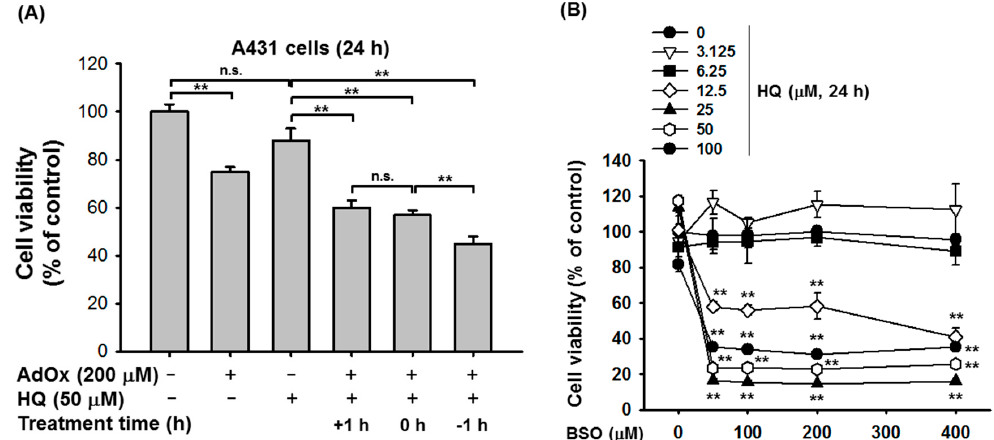
Figure 3. S ynergistic effect of HQ on the proliferation of A431 cells under AdOx- or BSO-treated conditions. ( A ) A431 cells were treated with HQ (50 μ M) and AdOx (200 μ M) for 24 h, and cell viability was determined via MTT assay. +1 h, HQ treatment 1 h after AdOx treatment; 0 h, HQ and AdOx treatment at the same time; and − 1 h, HQ treatment 1 h before AdOx treatment. ( B ) A431 cells were treated with the indicated doses of HQ and BSO for 24 h, and cell viability was determined via MTT assay. n.s., not significant; ** p < 0.01 compared to the normal or